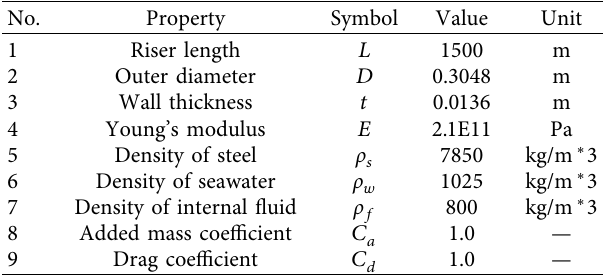
Table 1: Base set of system parameters.